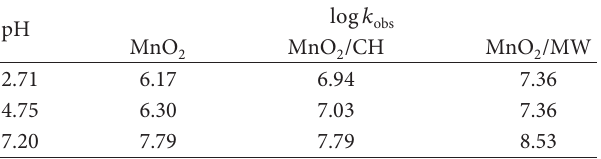
the observed and predicted variables (1/[MB] not reveal signi�cant difference (all P 0.05), con�rming the third-order kinetic model is of statistically reasonable for this reaction. Assuming a �rst-order reaction with respect to this because of the constant concentration of MnO were then calculated and are shown in Table 4. Values of log are plotted as a function obs of pH in Figure 5. e apparent reaction order with respect to H was determined as the slope of the straight line log = 𝑘𝑘 obs f (pH), and equal to 0.362, 0.161, and 0.157 for sole MnO + 𝑘𝑘 for (2) was calculated to be 1.76 /MW, respectively. e relative effects of MW on MB degradation are twofold. As the rate constant